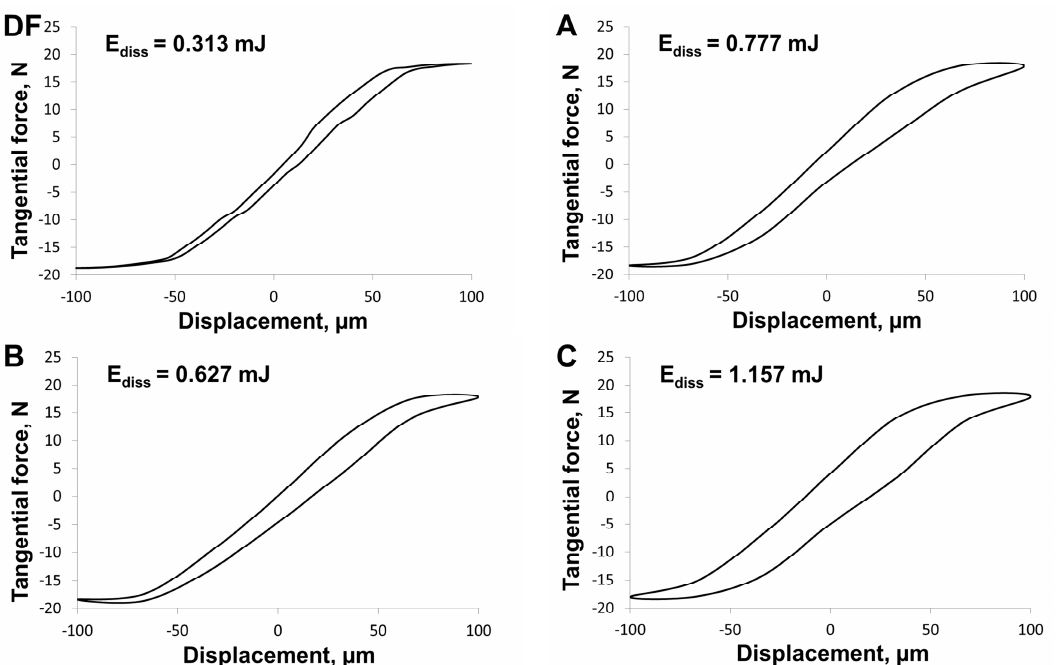
Figure 10. Energy dissipated during the single cycle of fretting (p = 30 MPa).